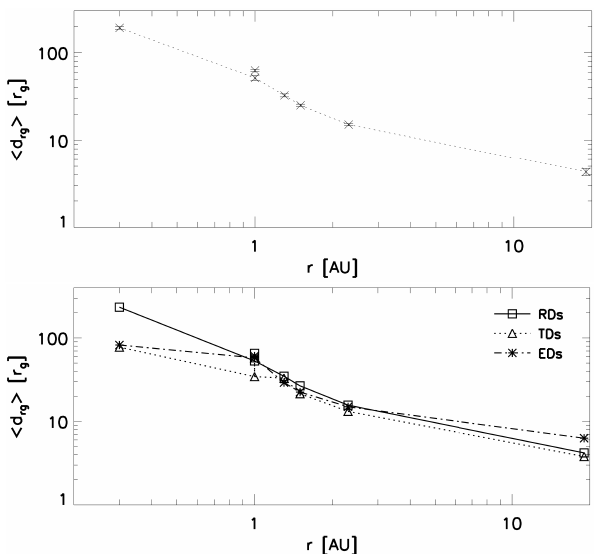
Fig. 15. Radial dependences of the mean thickness h d rg i normal- ized to the proton gyro radius r g for the overall distribution (top) and the DD types (bottom).